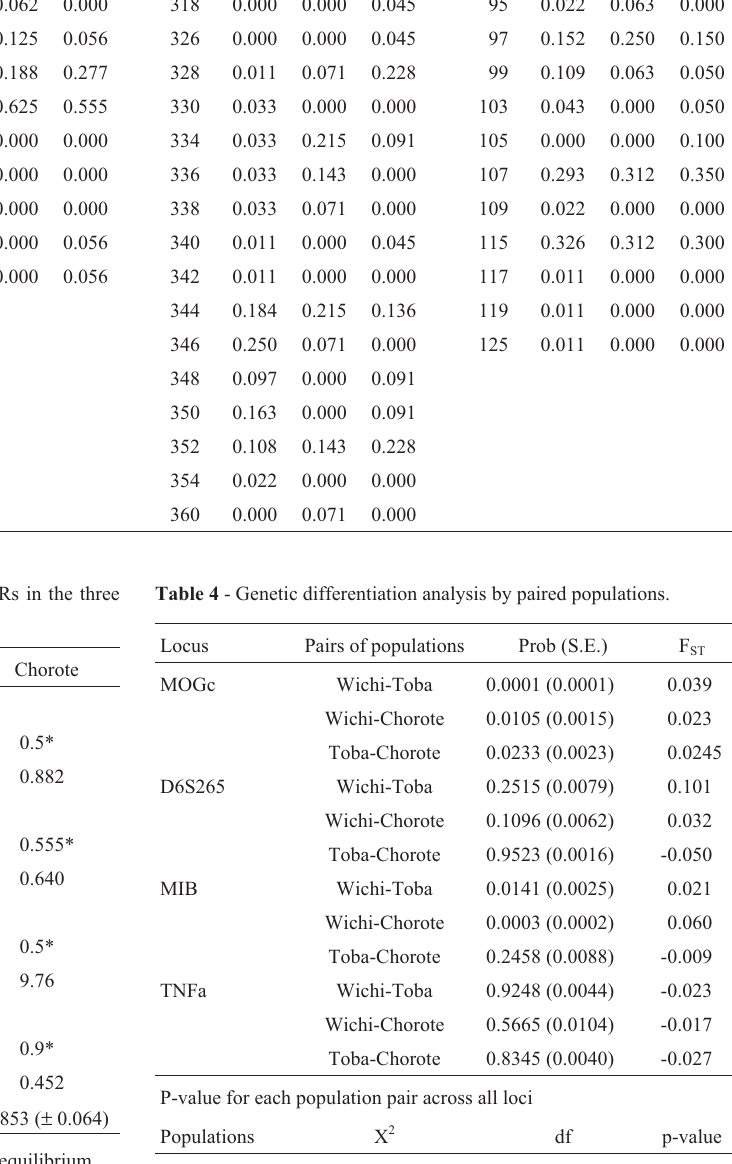
Table 2 - Allele frequencies for loci MOGc, D6S265, MIB, and TNFa in the three populations studied. MOGc D6S265 MIB TNFa Alleles Wichi Toba Chorote Allelles Wichi Toba Chorote Alleles Wichi Toba Chorote Alleles Wichi Toba Chorote